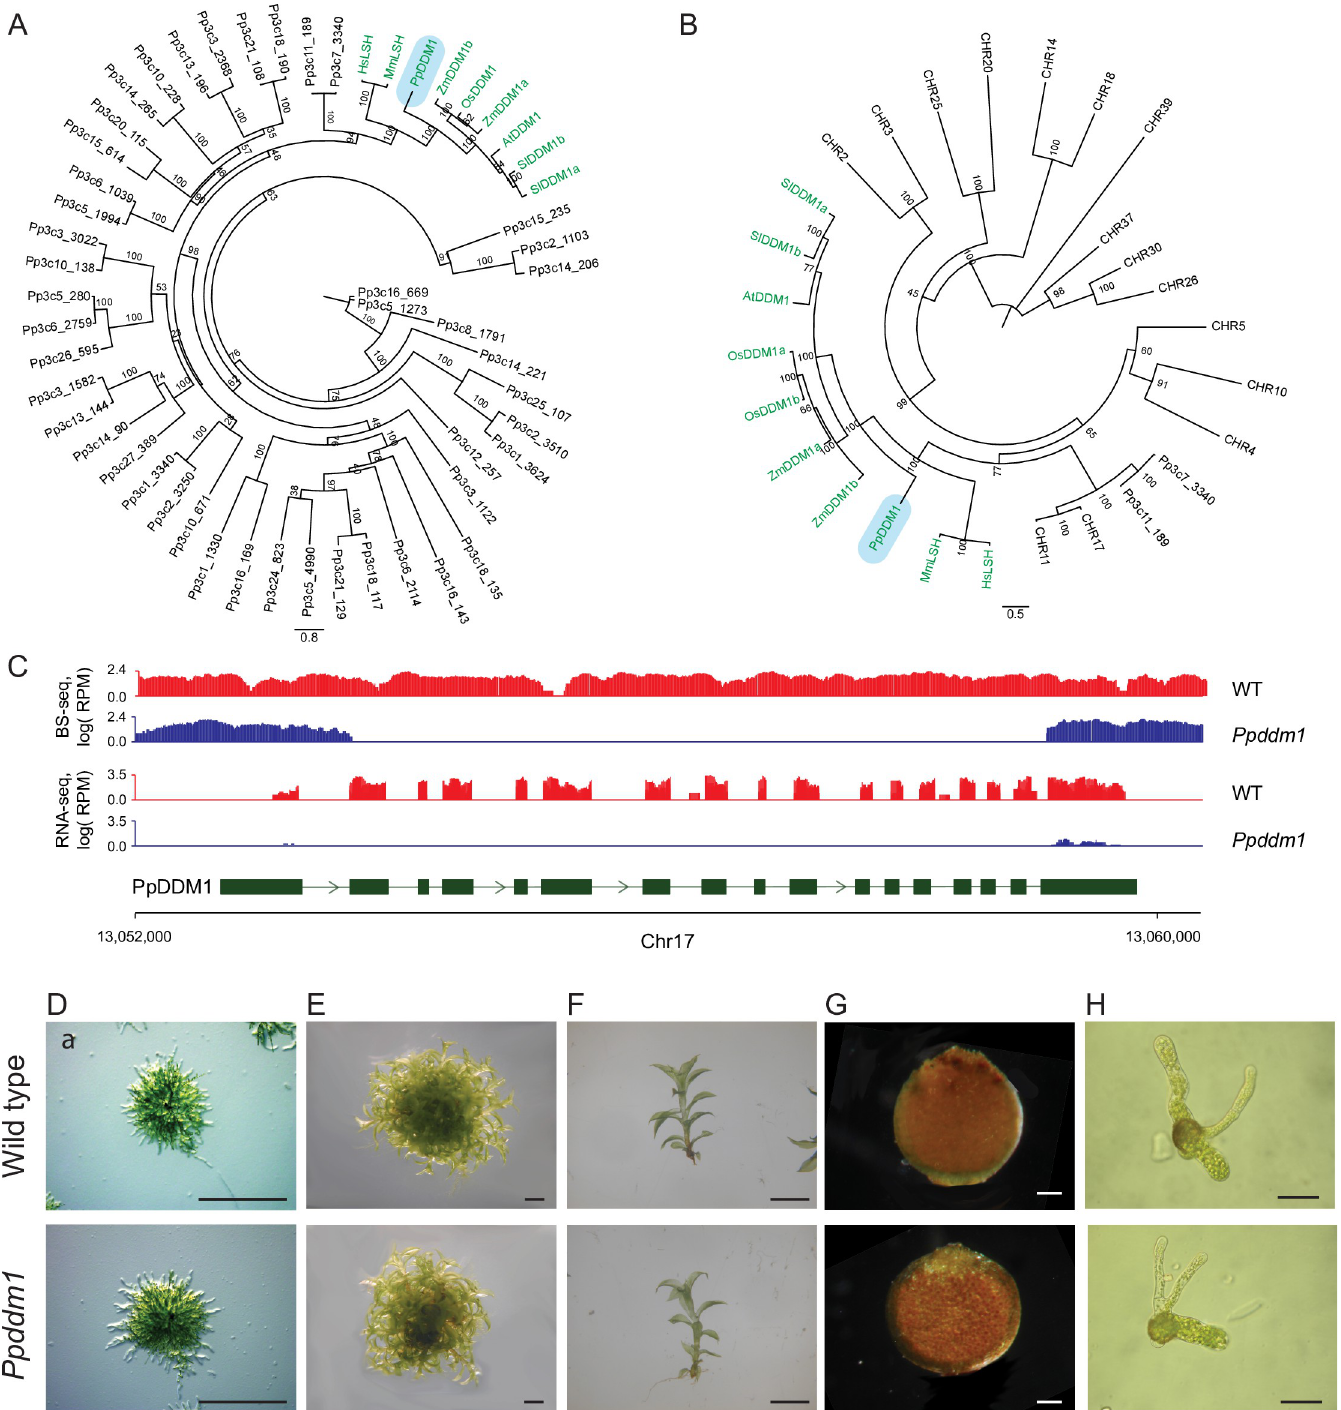
Fig 1. Physcomitrium patens DDM1 knockout develops normally. A. Phylogenic analysis of all P . patens SWI/SNF2 protein family members (including PpDDM1), and previously characterized DDM1 orthologues from flowering plants and mammals (LSH). The DDM1 clade is marked in green and PpDDM1 is highlighted in blue. B. Phylogenic analysis of A. thaliana SWI/SNF2 protein family members, PpDDM1, and additional DDM1 orthologs from flowering plants and mammals. DDM1 clade is marked in green and PpDDM1 is highlighted in blue. C. Coverage data from BS-seq and RNA-seq show the depletion of DDM1 sequences within the recombination region (Chr17:13053812-Chr:13059096). (D-H). Morphological phenotypic analysis of the wild type and Ppddm1 plants. Protoplast-recovered protonematal tissue (D), gametophore tissue (E), single gametophore (F), sporophyte (G), and germinated spores of T1 (H). Scales for D/E, F/H, and G, are 2 mm, 100 uM, and 50 uM,